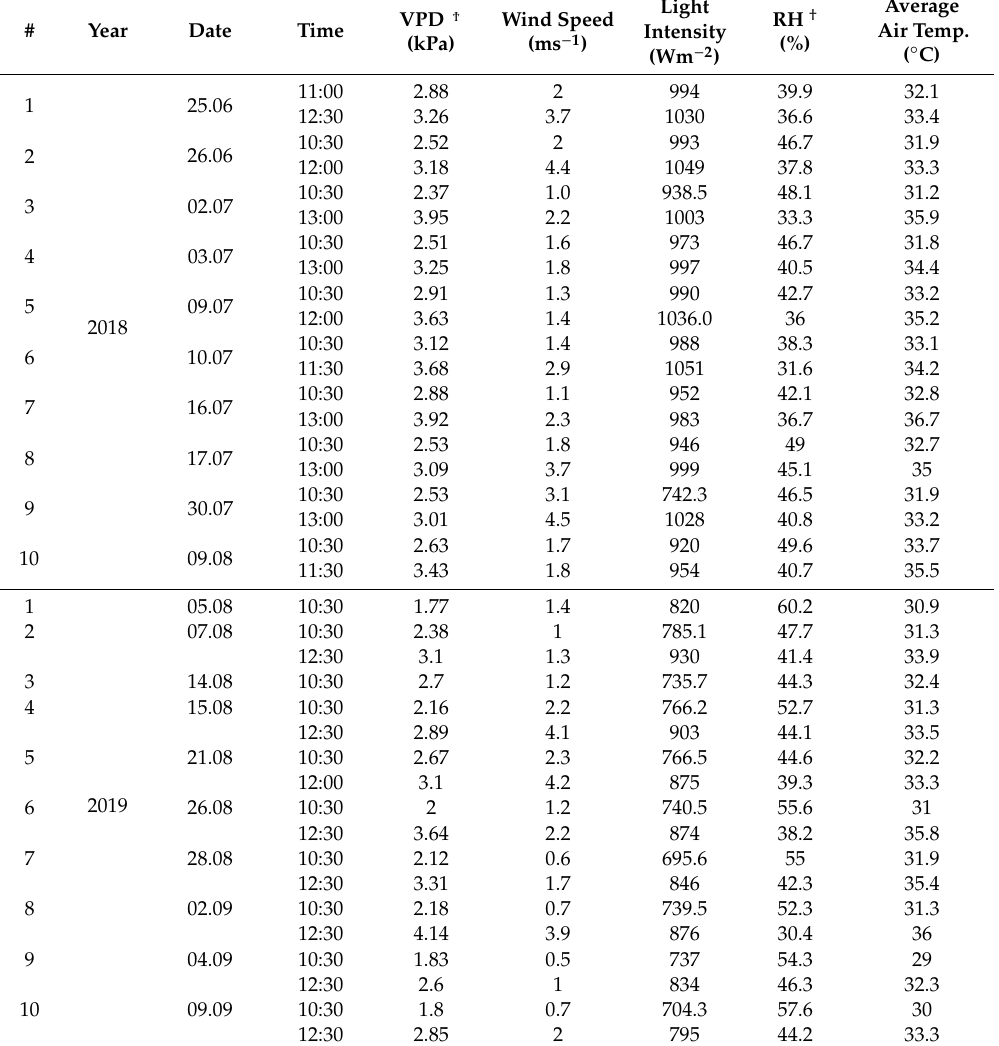
Table 1. Meteorological conditions during the experiment in cotton in 2018 and 2019.